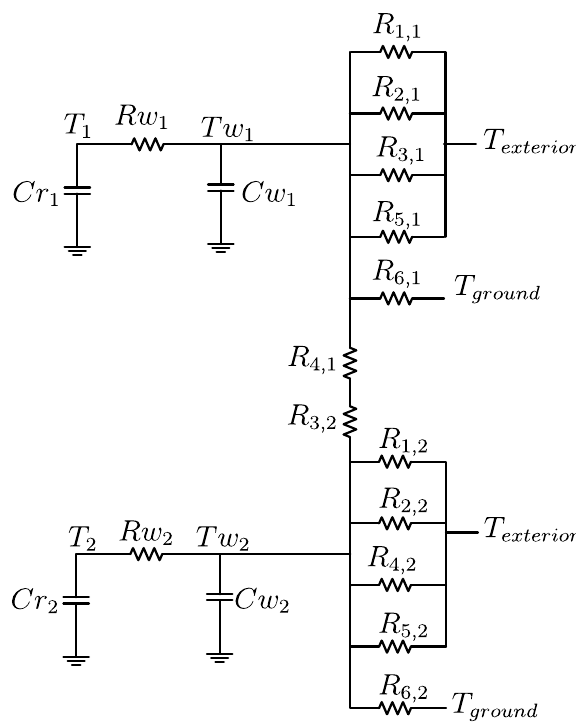
Figure 5. Circuit for a thermal zone with two